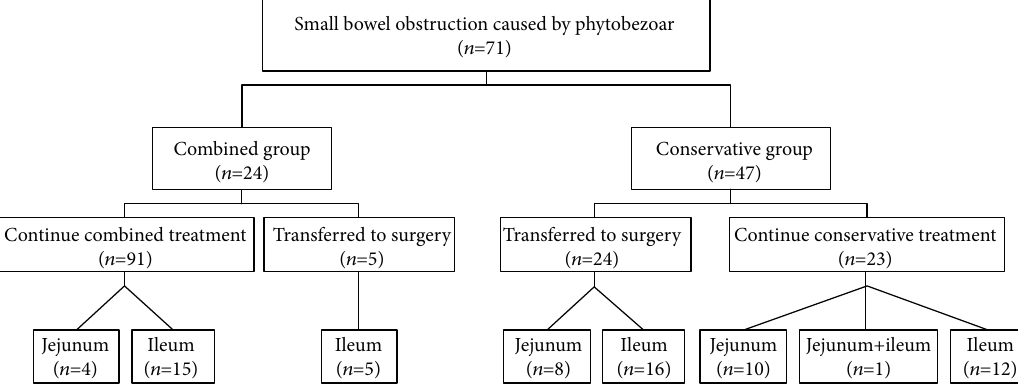
Figure 2: Flowchart of group